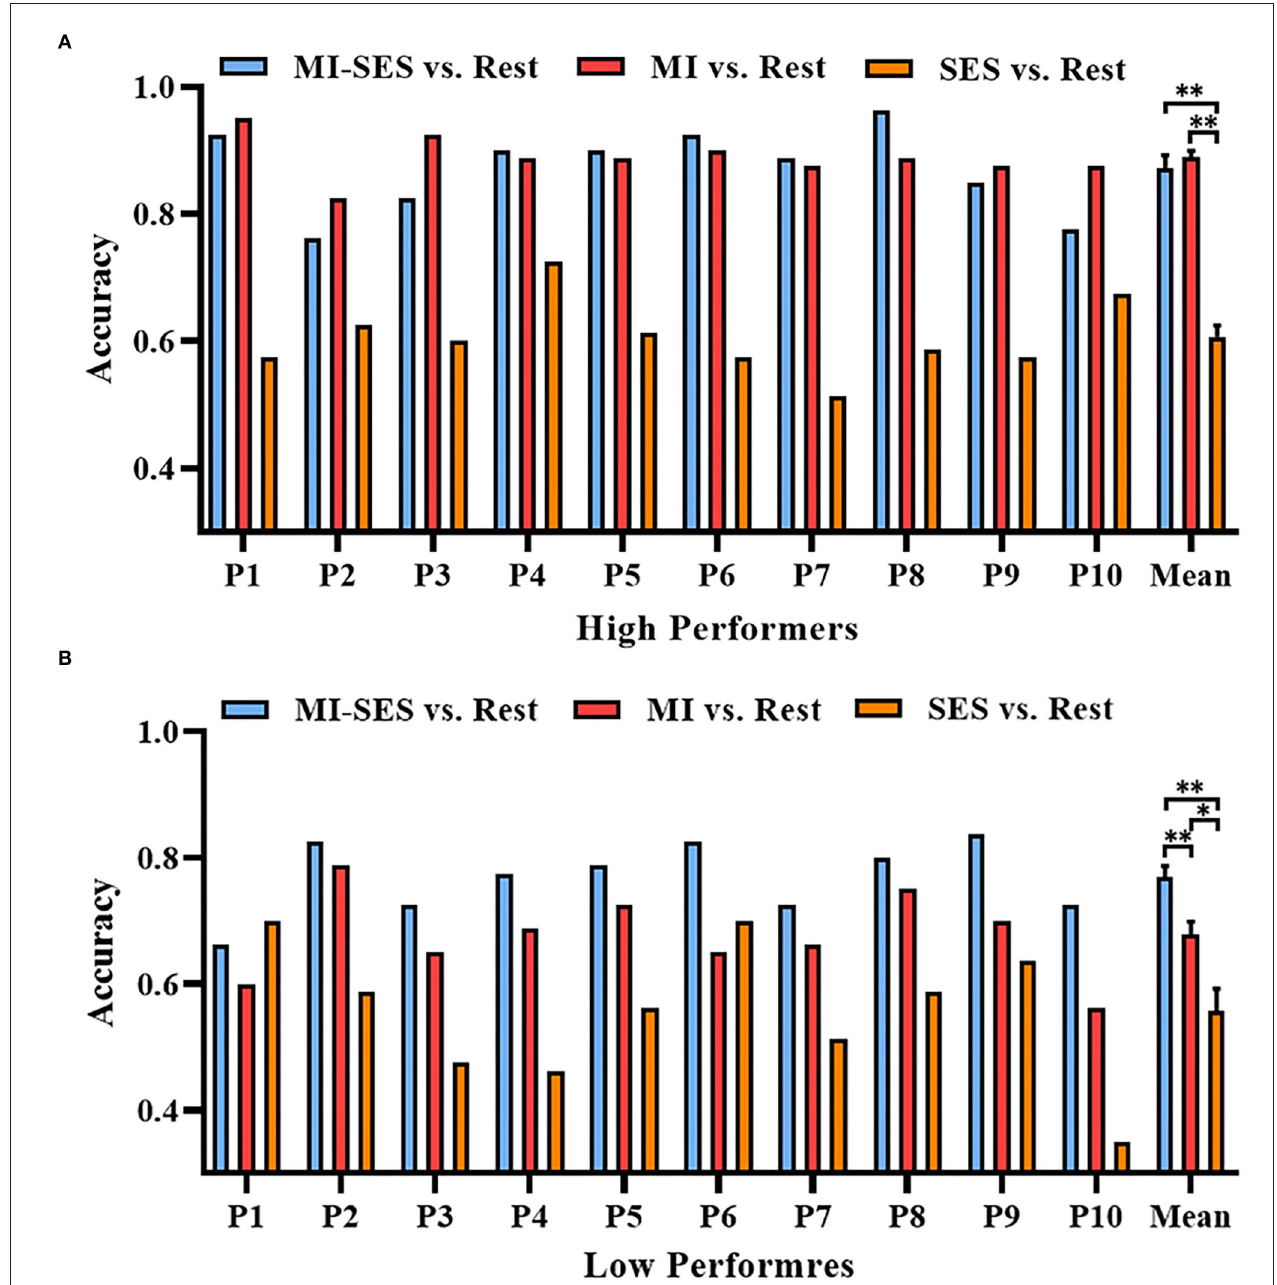
FIGURE 3 | Offline accuracies of distinguishing three conditions (MI-SES, MI, SES) from Rest condition. (A) Classification accuracy results in High Performers group. (B) Classification accuracy results in Low Performers group. Error bars represent standard error of mean. “*” indicates p < 0.05, “**” indicates p <